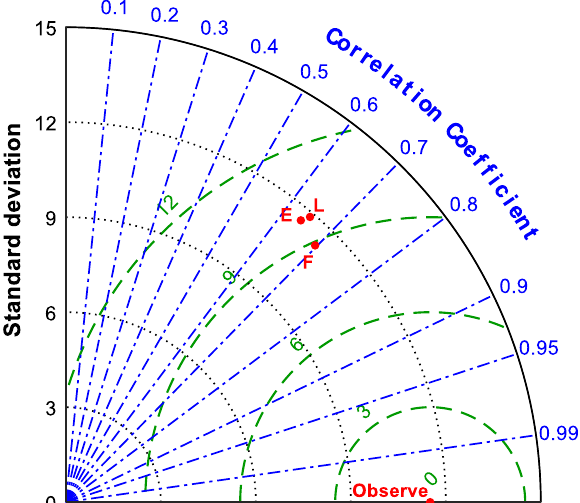
Figure 3. Taylor diagram showing a comparison of daily Dongting Lake basin values from F (IMERG-F), E (IMERG-E), and L (IMERG-L) with respect to the observed data. There was an obvious correlation between satellite precipitation data and observation data. The CC daily value of IMERG-F reached 0.70, slightly higher than that of IMERG-E (about 0.64) and IMERG-L (about 0.65). IMERG-F had a C-RMS of 8.89 mm and an SD of 11.30 mm, which were lower values than those of the other satellite products. The respective RB values of IMERG-E, IMERG-L, and IMERG-F were − 5.57, − 5.93, and 3.75. IMERG-F overestimated the values, while the other satellite products underestimated the values. Overall, at a daily scale, the three products were very close to the data from the ground observation sites. IMERG-F performed better than other satellite